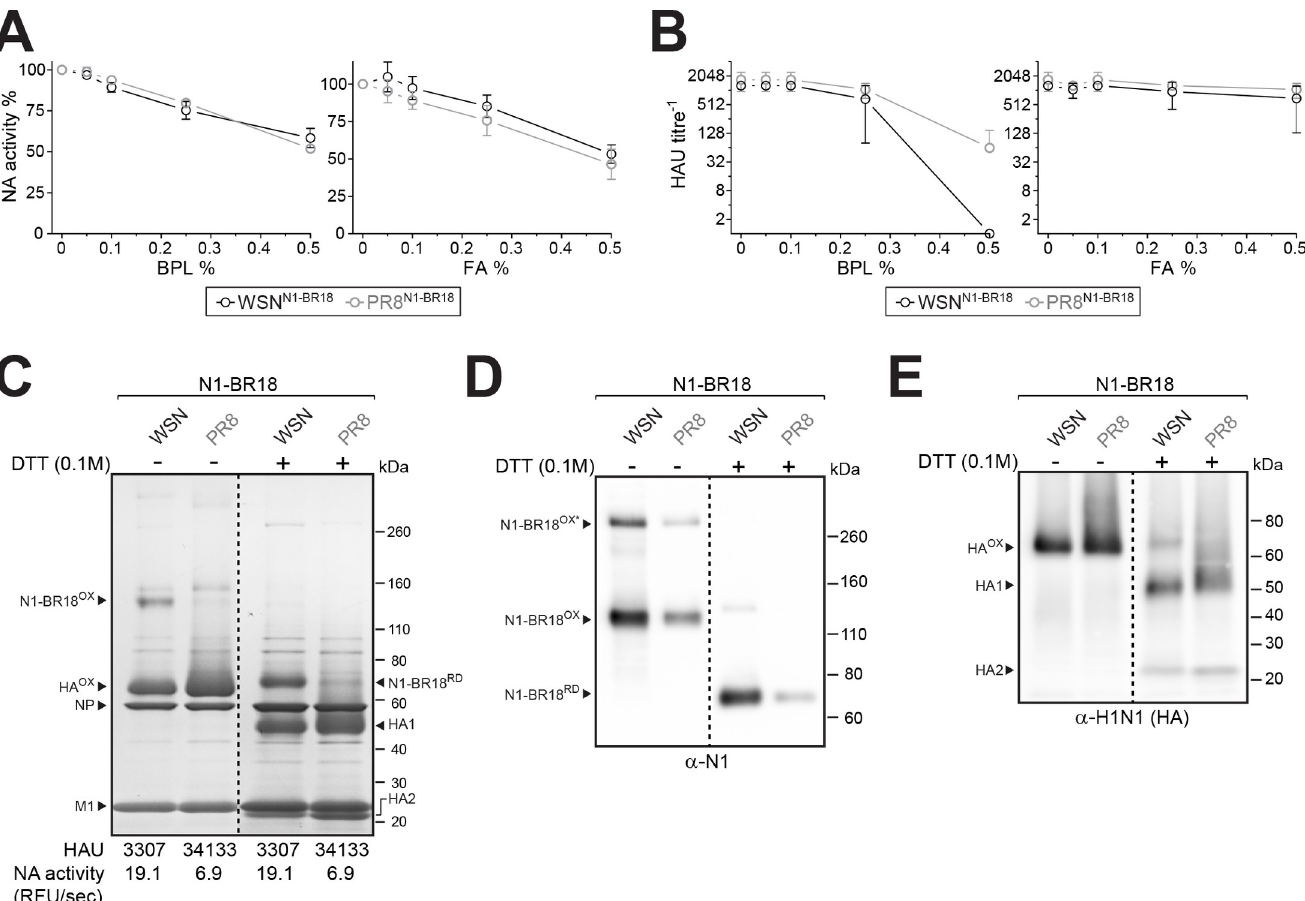
Fig 2. Egg produced WSN N1-BR18 virions incorporate more NA than PR8 N1-BR18 virions. A and B. Graphs showing viral NA activity ( A ) and HAU titres ( B ) of the indicated viruses after treatment with increasing concentrations of β -propiolactone (BPL) and formaldehyde (FA). Treatment was done in allantoic fluid overnight at 4˚C. NA activity of the untreated sample was set to 100%. Data from three independent biological replicates are displayed as the mean (circle) ± SD (error bars). C. Representative Coomassie stained gel of the purified BPL inactivated virions (5 μ g per lane), untreated or reduced with DTT prior to resolution on a 4–12% SDS-PAGE gel. Oxidized (OX) and reduced (RD) forms of NA (N1-BR18) and HA are indicated with the viral proteins NP and M1. Note HA resolves as two polypeptides (HA1 and HA2) after reduction (+DTT). HAU titres and NA activity values are means from 3 independently purified batches with equal protein concentrations (1 mg/ml). D and E. Representative NA ( D ) and HA ( E ) immunoblots of the purified virions (0.5 μ g per lane), untreated or reduced with DTT prior to SDS-PAGE. Oxidized and reduced NA and HA bands are indicated. ( D ) Asterisk indicates SDS resistant NA homo-tetramers that resolve under non-reducing conditions. ( E ) Note the H1N1 antisera has some reactivity towards